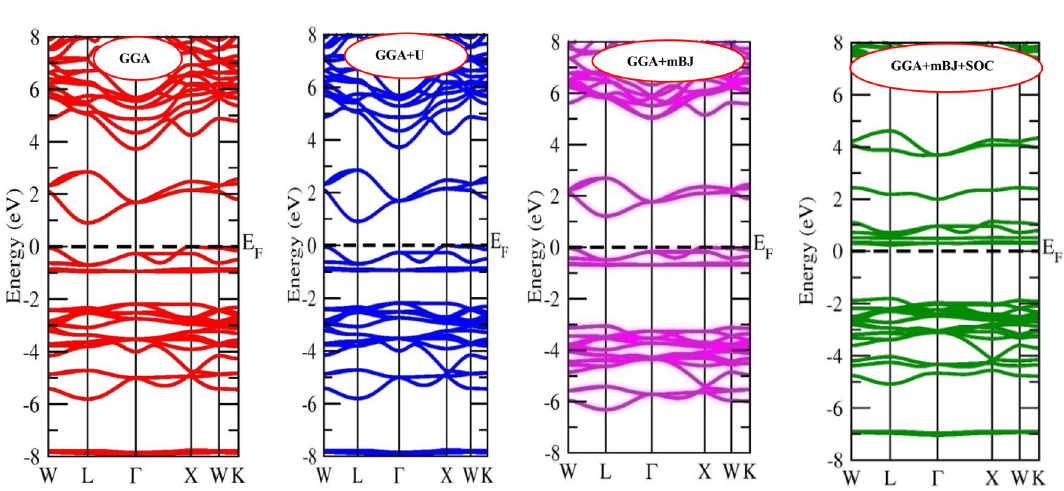
Figure 3. Band structure of Cs 2 CuBiCl 6 calculated by GGA, GGA + U and GGA + mBJ and GGA + mBJ + SOC